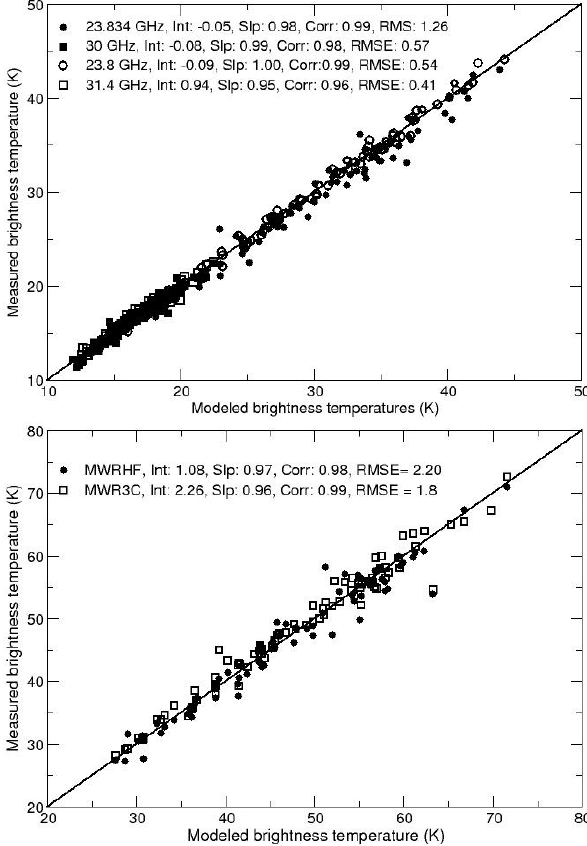
Fig. 6. Top: brightness temperatures measured and modeled at 23.834 and 30GHz (MWR3C, N = 81) and at 23.8 and 31GHz (MWR, N = 84). Bottom: measured and modeled brightness tem- peratures at 90GHz (MWRHF, N = 73) and at 89GHz (MWR3C, N = 82). Data were collected at the SGP site during August and October